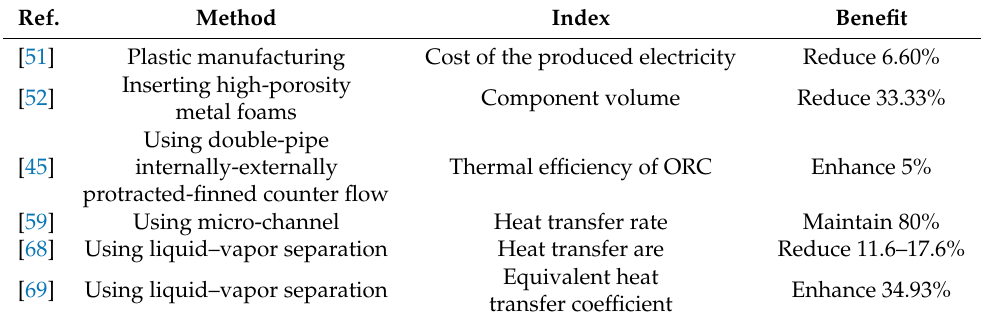
Table 1. Relevant research on the heat transfer enhancements and/or novel heat exchangers. Ref.